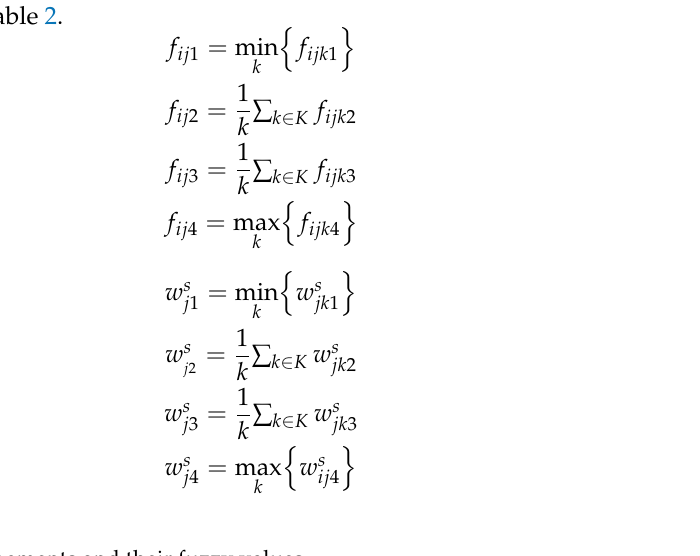
Table 2. Linguistic judgements and their fuzzy values. Linguistic Judgement Trapezoidal Fuzzy Scale Rate Trapezoidal Fuzzy Scale Low (0, 0.1, 0.2, 0.3) Poor (0, 0.1, 0.2, 0.3) Medium Low (0.2, 0.3, 0.3, 0.4) Medium Poor (0.2, 0.3, 0.3, 0.4) Medium (0.3, 0.4, 0.5, 0.6) Fair (0.3, 0.4, 0.5, 0.6) Medium High (0.5, 0.6, 0.7, 0.8) Medium Good (0.5, 0.6, 0.7, 0.8) High (0.8, 0.9, 0.9, 1) Good (0.8, 0.9, 0.9,